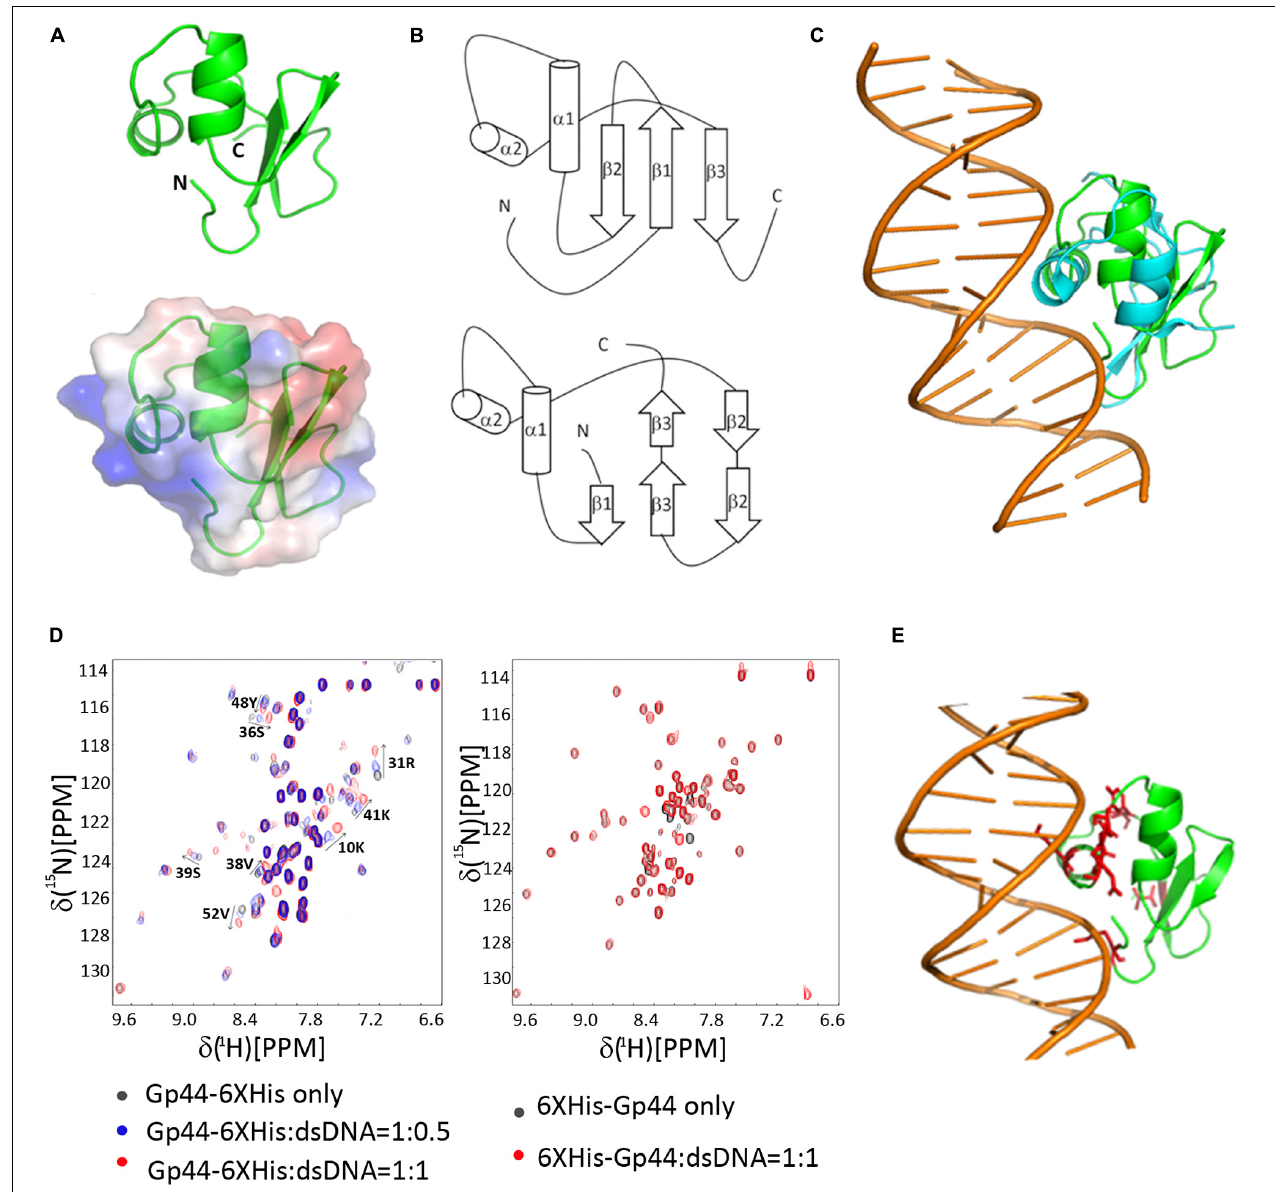
FIGURE 3 | NMR-derived three-dimensional structure of Gp44NT and DNA interaction (A) A cartoon representation of Gp44NT structure (top), and basic electrostatic surface distribution (bottom), calculated using the vacuum electrostatics program in Pymol, version 0.99rc6. Red represents residues with negatively charged sidechain and blue indicate positively charged amino acids. (B) Topologies of Gp44NT (top) and Xis (bottom). (C) Superimposed Gp44_NT (green) and Xis/DNA complex (cyan, PDB ID: 2OG0, DNA major and minor grooves included). (D) Left: Overlay of 2D 1 H– 15 N HSQC spectra of Gp44NT-His with and without dsDNA. Black: no dsDNA; Blue: 0.5 equivalent of dsDNA added and Red: 1 equivalent of dsDNA added. Spectra recorded at pH 6.5, 298K. Right: Overlay of 2D 1 H– 15 N HSQC spectra of His-Gp44 1 - 55 with and without dsDNA. Black: no dsDNA and Red: 1 equivalent of dsDNA added. Spectra recorded at pH 6.5, 298K. (E) A model of Gp44NT/dsDNA interaction created by using Xis/DNA complex structure (PDB ID: 2IEF). Peaks experience most chemical shift perturbation is highlighted in